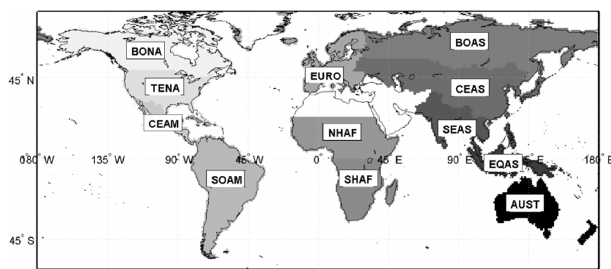
Figure 13. Regions used for interannual variability